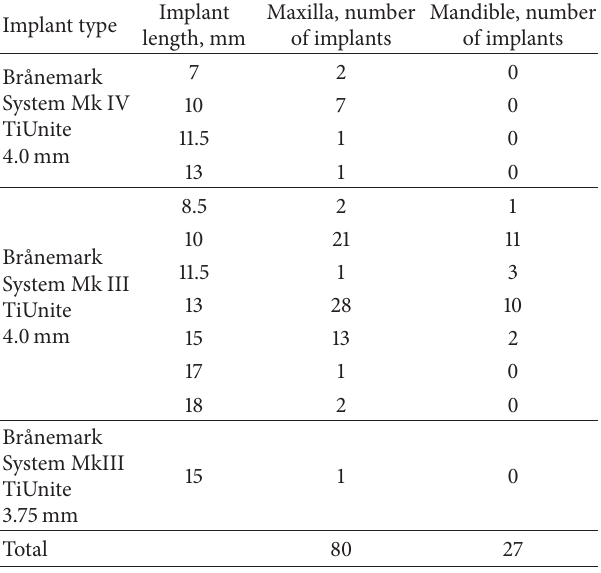
Table 1: Distribution of the implants used in this study. Implant